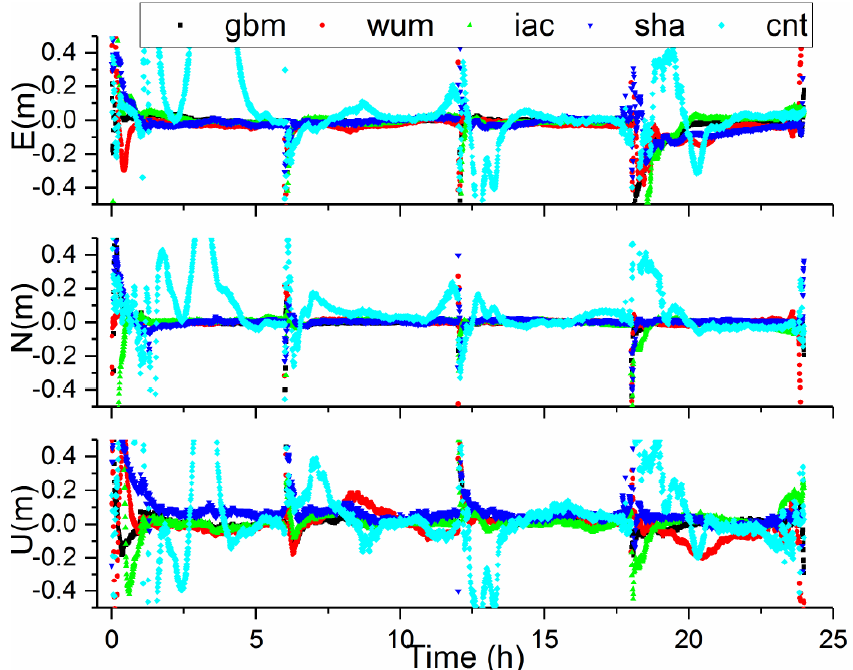
Figure 7. Positioning errors obtained from BDS-3 PPP in kinematic mode with different products on DOY 288 at